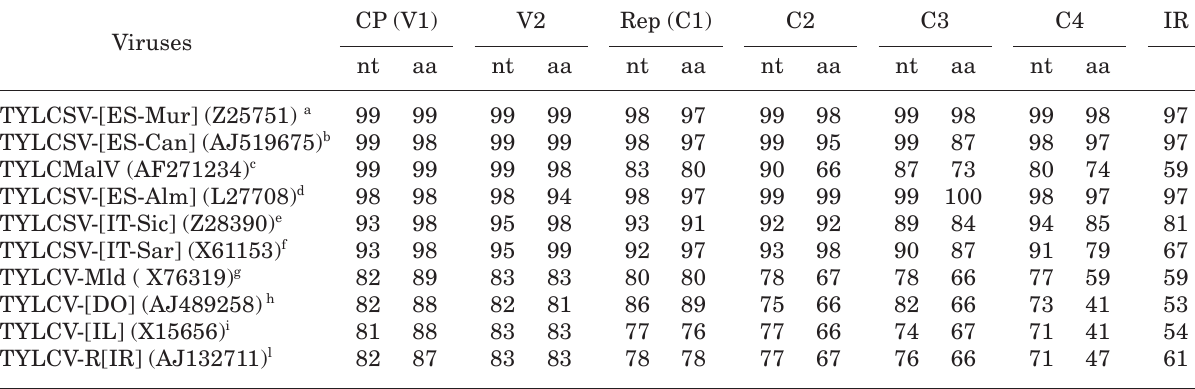
Table 2. Comparison between TYLCSV from Morocco and other members of the TYLCV complex. Percent nucle- otide (nt) identities and derived amino acid (aa) between open reading frames (V1 and V2, C1 to C4) and intergen- ic region